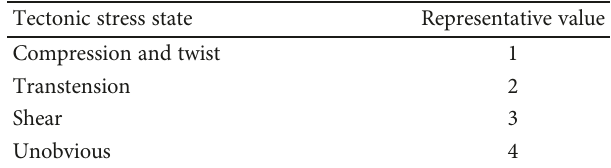
Table 7: Tectonic stress state.